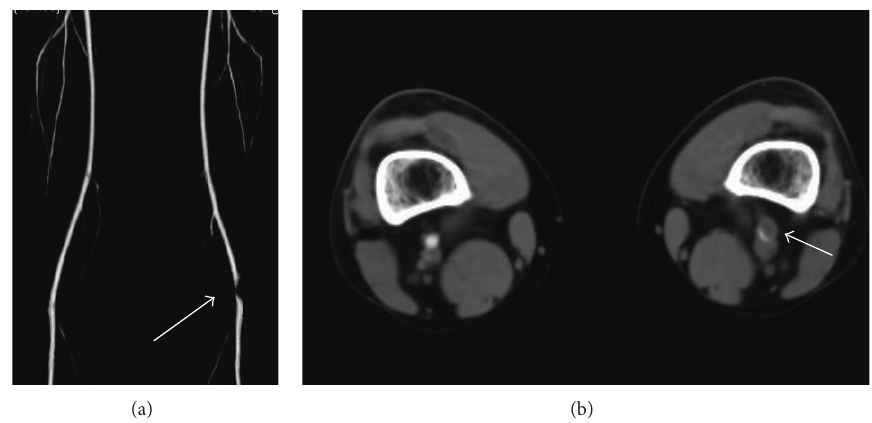
Figure 2: Computed tomography shows (a) the occlusion of the left popliteal artery (white arrow) and (b) a cystic mass compressing the popliteal artery (white arrow).